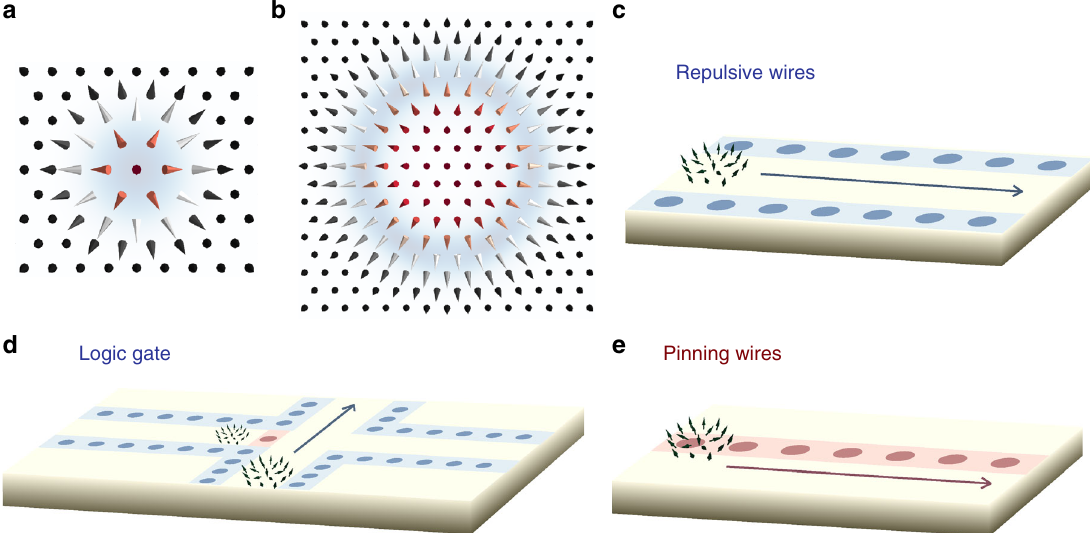
Fig. 4 Spintronic devices with defects guiding the skyrmion motion. a , b Non-collinear regions (blue area) de fi ning pinning or repulsion depending on the chemical nature of the impurities. A pinning impurity can lock a skyrmion within the blue region while a repulsive impurity can pin a large skyrmion on the core region, which is a local minimum energy. c – e Combination of different energy-landscapes to engineer spintronics devices. c Repulsive lanes (blue) can con fi ne the motion of skyrmions in a desired direction. d Pinning (red) usually hinders skyrmion mobility and can be used to decelerate them. e Pinning lanes (red) can be a medium for skyrmions motion